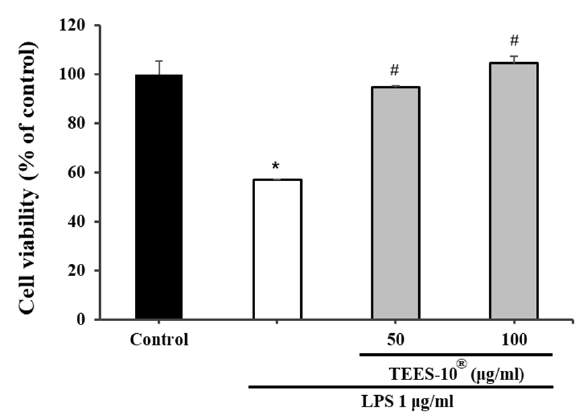
Figure 4. Effects of TEES-10 ® on the viability of lipopolysaccharide (LPS)-treated PDL cells. Effects of 50 and 100 µ g/mL of TEES-10 ® on LPS-treated PDL cell viability. PDL cells were exposed to 1 µ g/mL of LPS. Each bar indicates the mean ± SEM. ( n = 5). * p < 0.05 compared with the sham control group. # p < 0.05 compared with the 1 µ g/mL LPS-treated group.